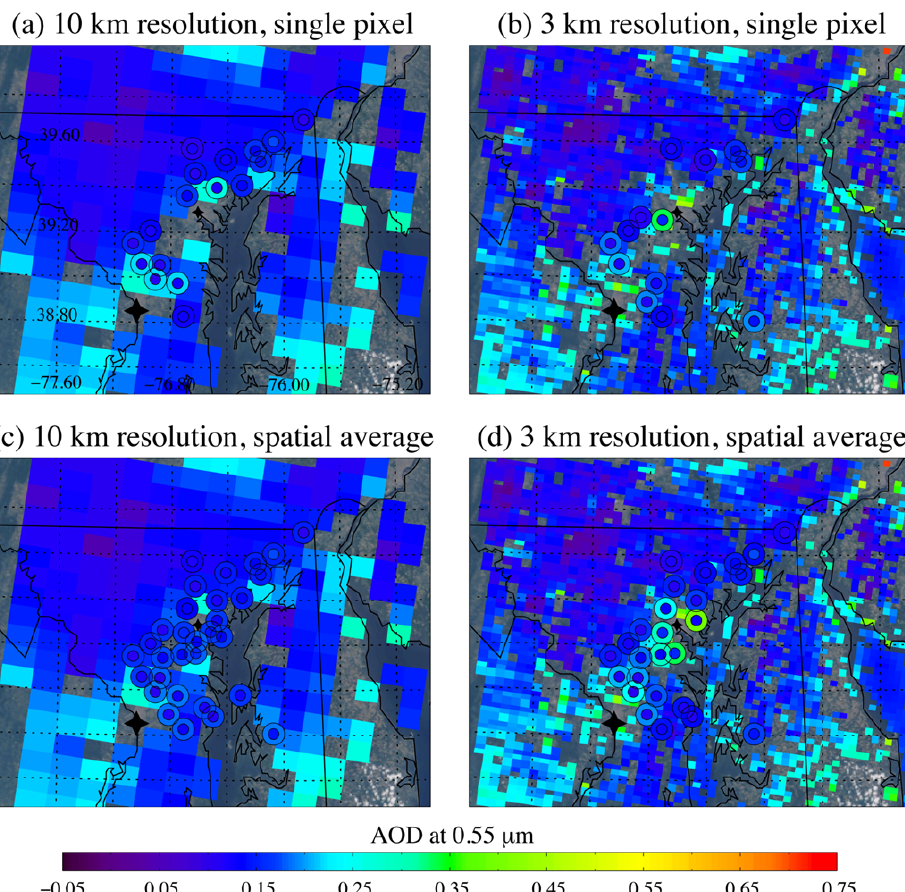
Fig. 2. AOD at 0.55µm observed by MODIS-Terra on 1 July 2011 at 15:35UTC is plotted at the 10km resolution ( a and c ) and 3km resolution ( b and d ). MODIS/SP collocations are plotted in the circles. In (a–d) , the inner circle is the SP temporally averaged AOD, which is average of ≥ 2SP measurements within 30min of MODIS overpass. In (a) and (b) , the outside circle is the AOD of the MODIS pixel containing the SP site. In (c) and (d) , the outer circle is the spatial average of a MODIS AOD in a 5 × 5 pixel box around the SP station. Only land pixels with a QA=3 are used in the collocation. Washington D.C. is shown with the large black star and Baltimore, MD is shown with the small black star. The true color image, created from the MODIS red, green and blue bands, is shown in the